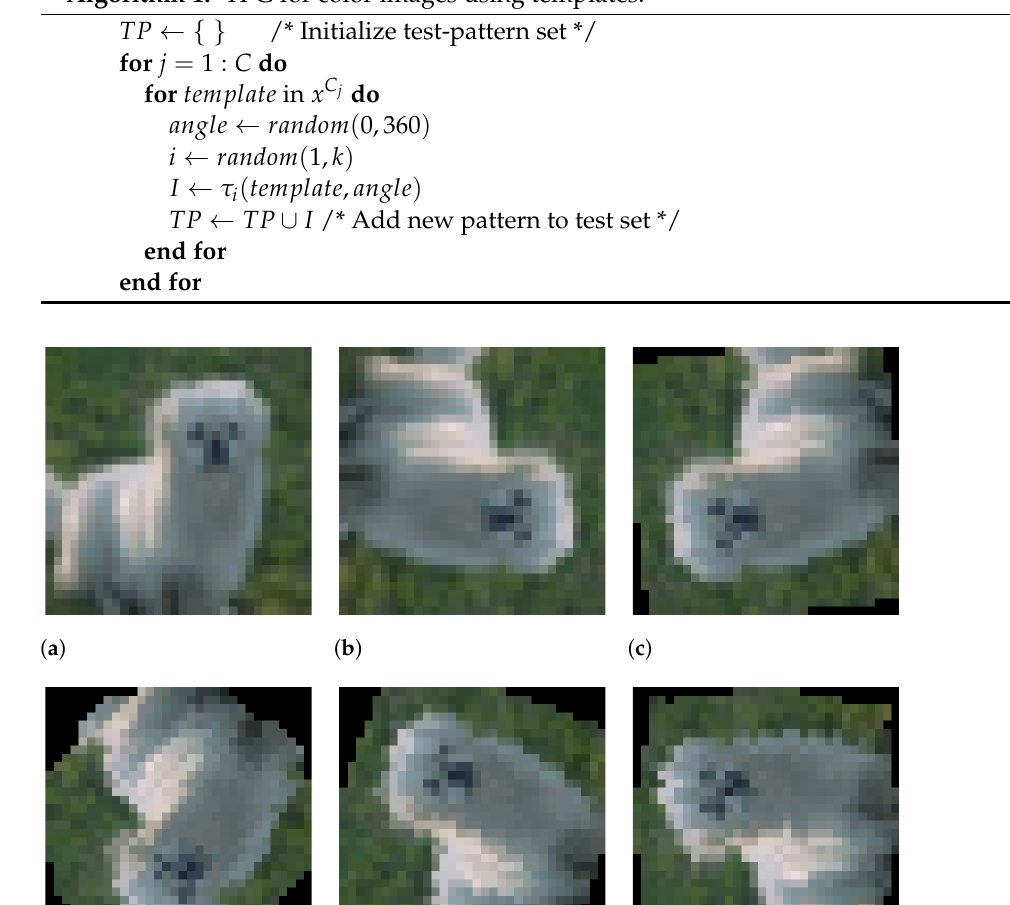
Algorithm 1: TPG for color images using templates.